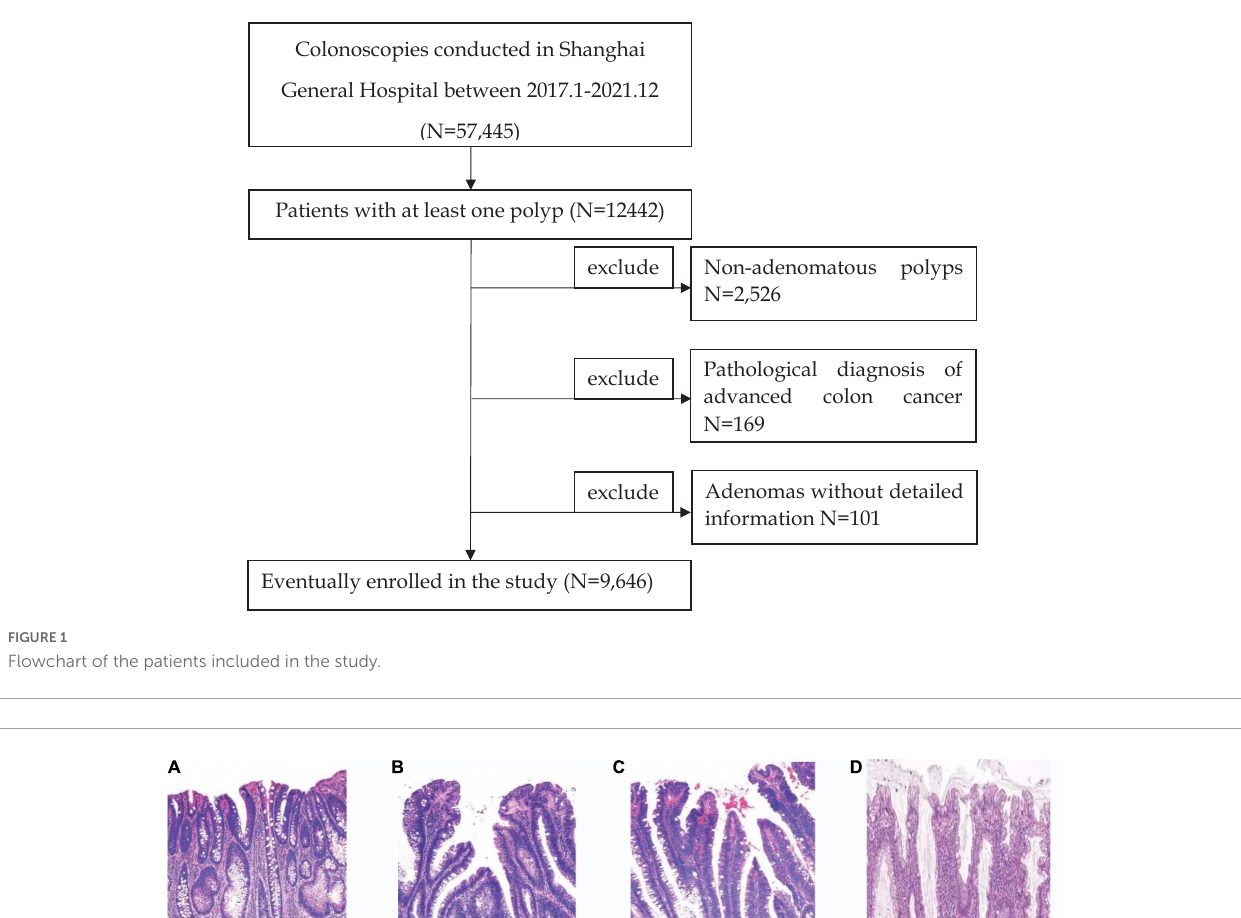
FIGURE2 Histology: (A) Tubular, (B) tubulovillous, (C) villous, and (D) serrated adenomas.